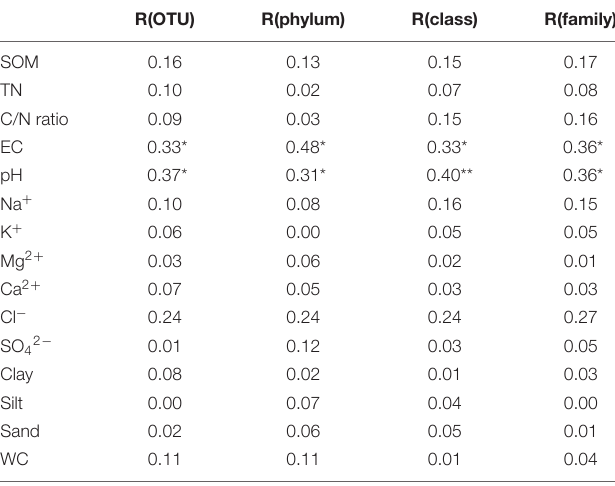
TABLE 4 | The Mantel test between fungal community and environmental